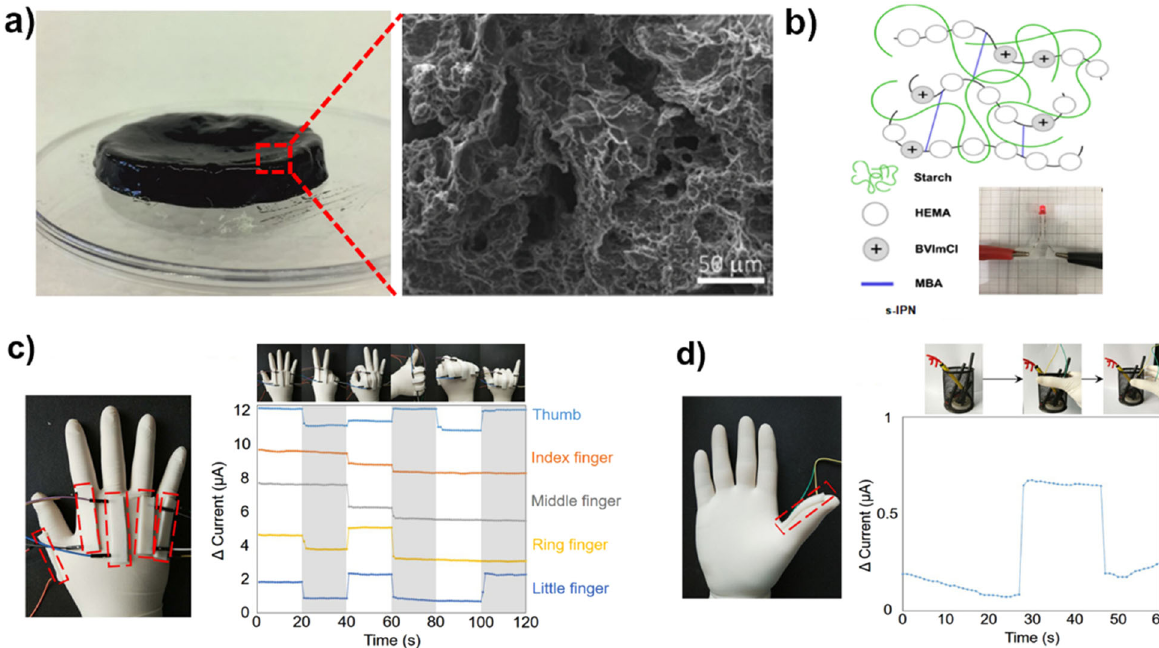
Fig. 8 Conducting and sensing elements based on starch gels. a Photograph and SEM images of the starch/graphene hydrogels. Reproduced with permission 147 . Copyright 2018, Elsevier. b Chemical structure of the S-IPNs hydrogel with electronic and ionic conductivity. Reproduced with permission 45 . Copyright 2019, American Chemical Society. c Photographs of starch hydrogel sensors on the glove and the responding current signal under different hand con fi gurations; d photographs and signal of starch hydrogel sensor to monitor the hand grasping a pencil vase. Reproduced with permission 151 . Copyright 2019, Elsevier.